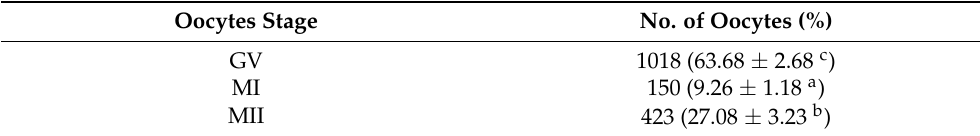
Table 2. Nuclear maturation of donkey oocytes after in vitro